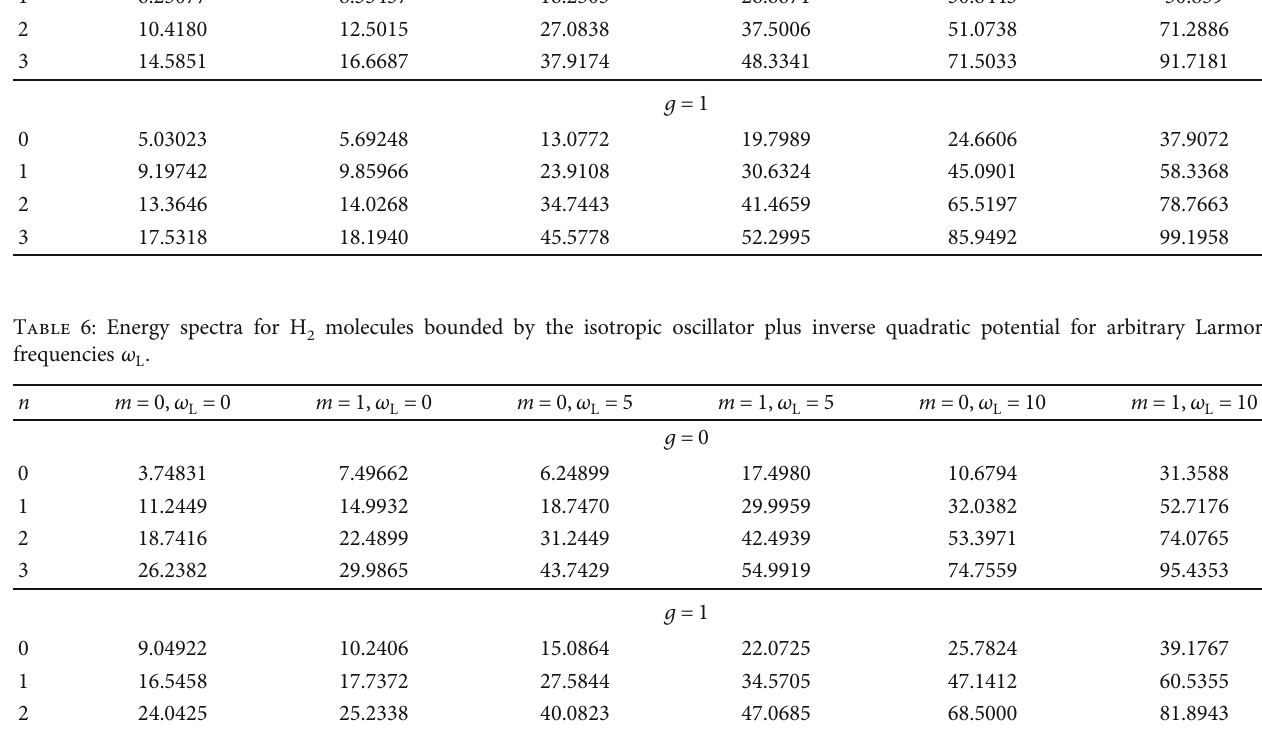
Table 7: Expectation values h r 2 i for CO, HCl, I arbitrary Larmor frequencies ω